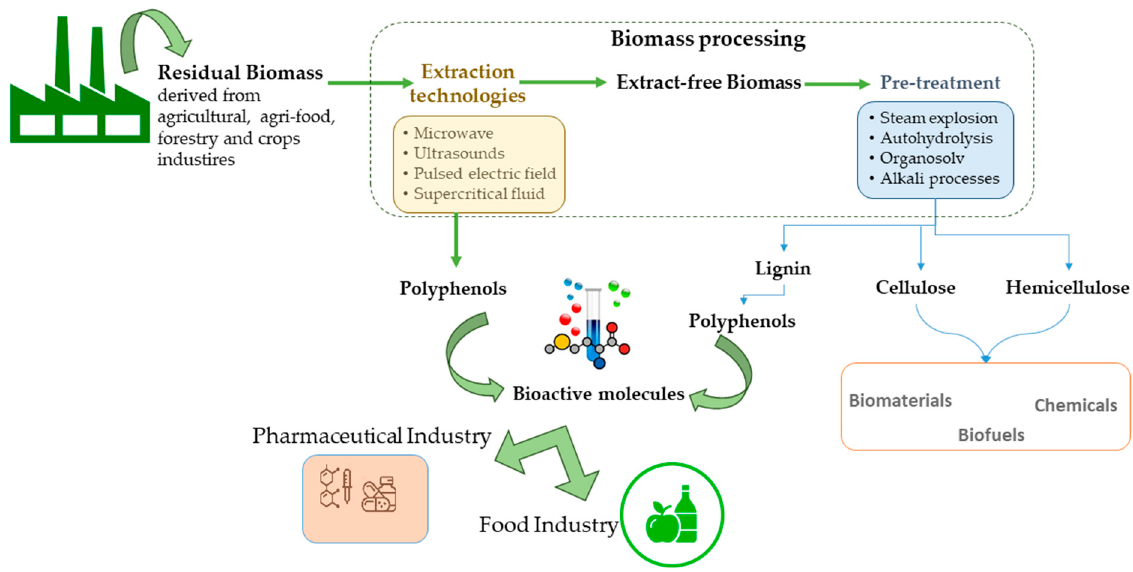
Figure 2. Polyphenolic compound extraction from residual biomass within a biorefinery scheme.